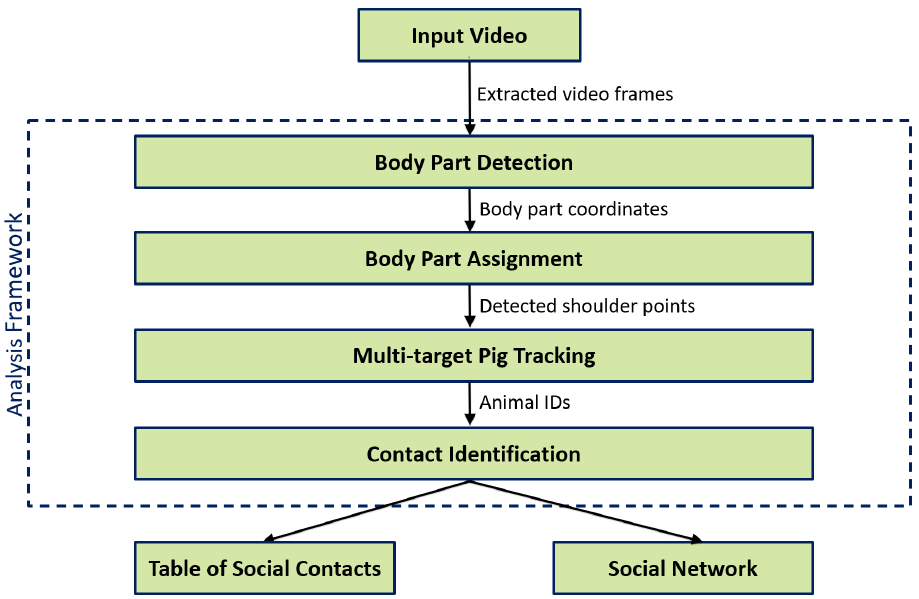
Figure 1. Flowchart of the analysis applied in this